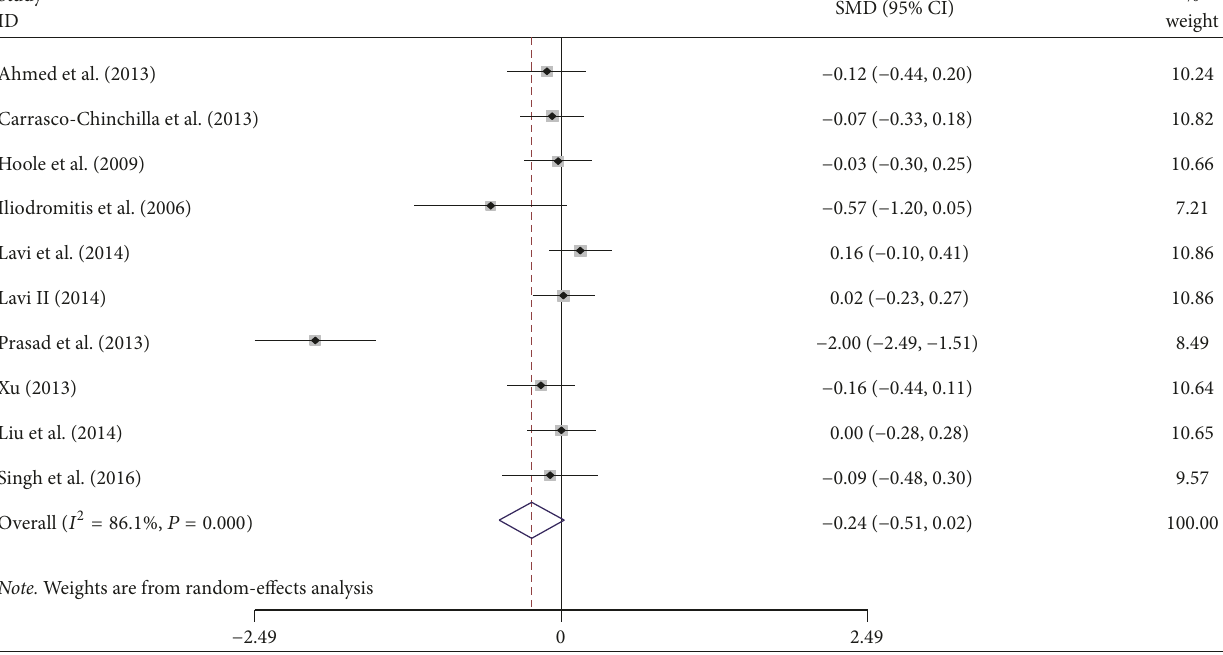
Figure 6: Forest plot for CRP as SMD after PCI. CRP: C-reactive protein; SMD: standardized mean difference.